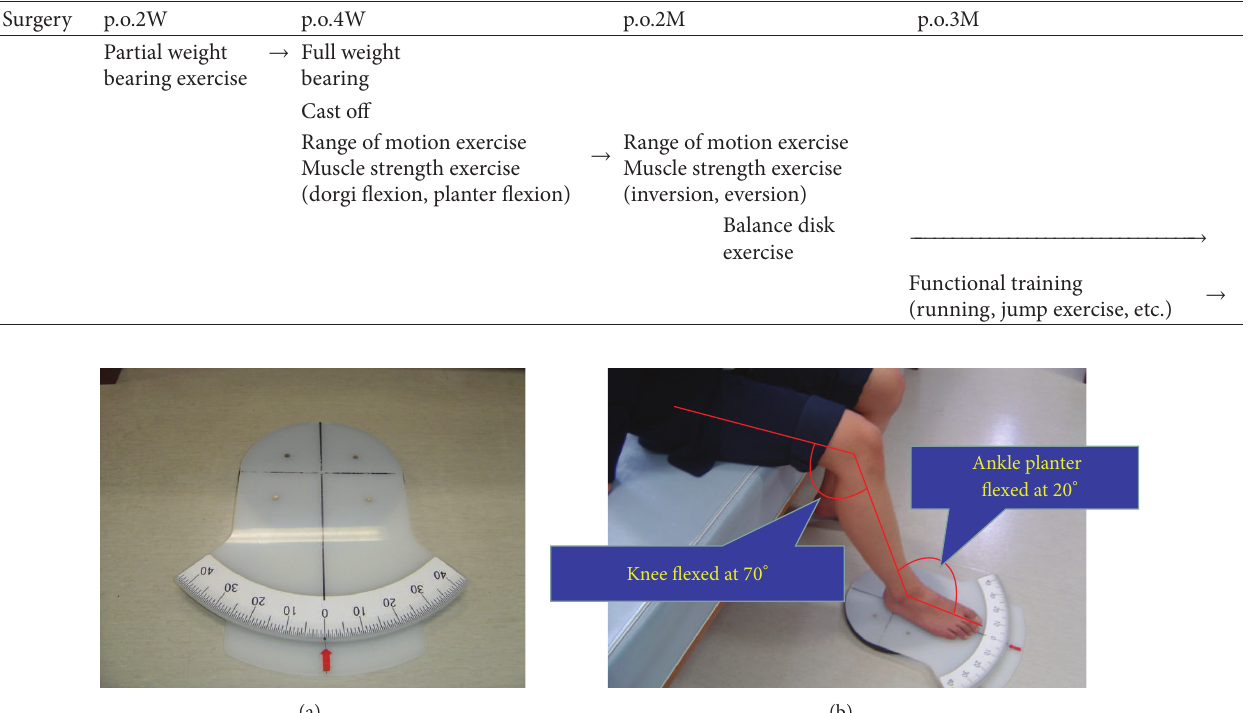
Table 2: Rehabilitation protocol after surgical intervention.